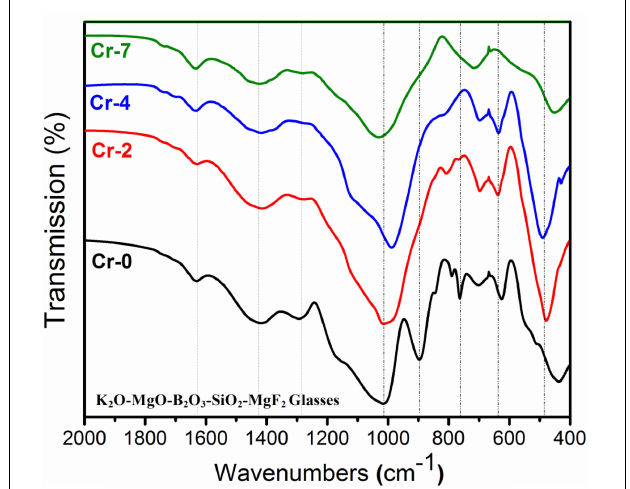
FIGURE 5 | FTIR pattern (in 400–2000 cm - 1 ) of K 2 O-MgO-Al 2 O 3 -B 2 O 3 - SiO 2 -F glasses with and without containing K 2 Cr 2 O 7 content; showing significant variation in the appearance of transmission band with K 2 Cr 2 O 7 concentration (for composition see Table 1 ).